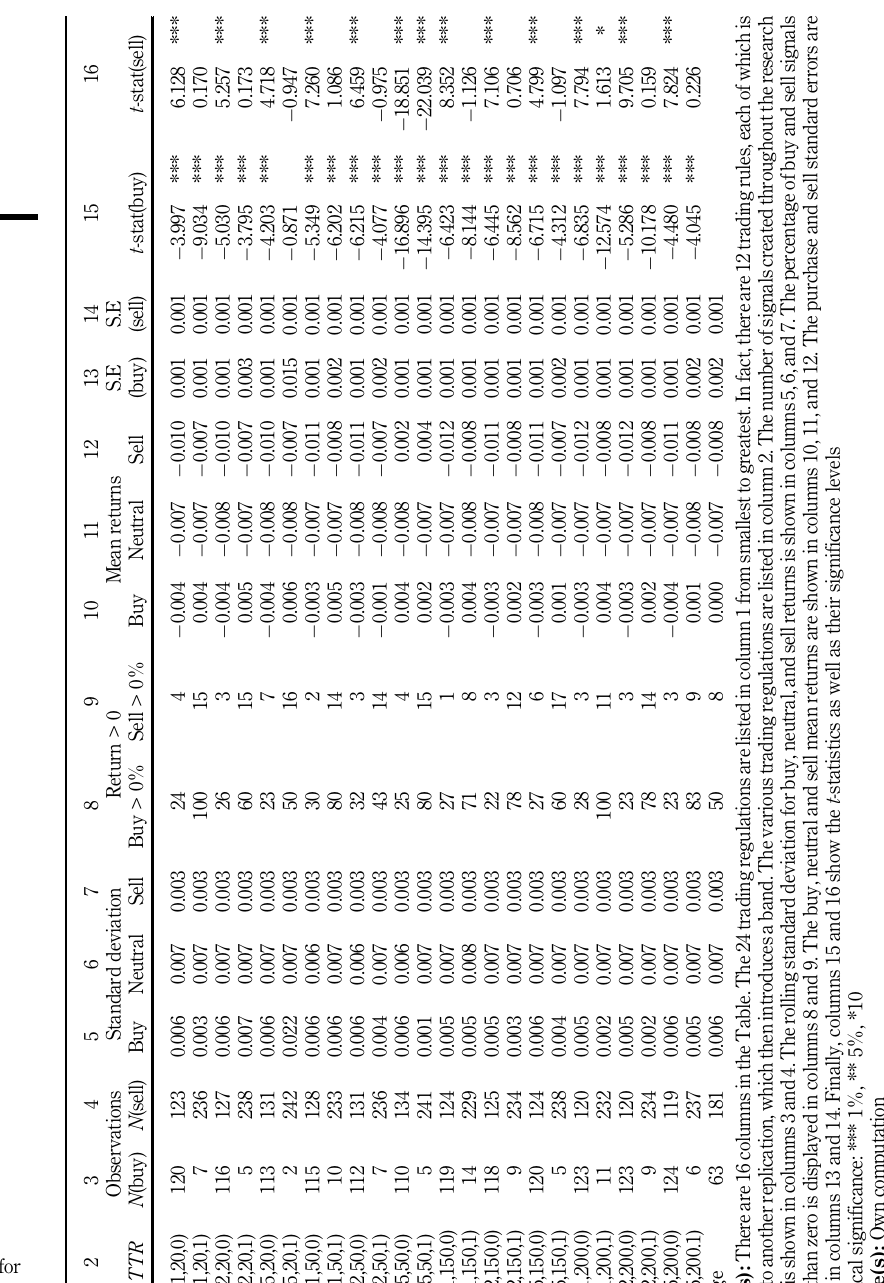
Table 5. BTC/ZAR results for BBL ’ s mean difference